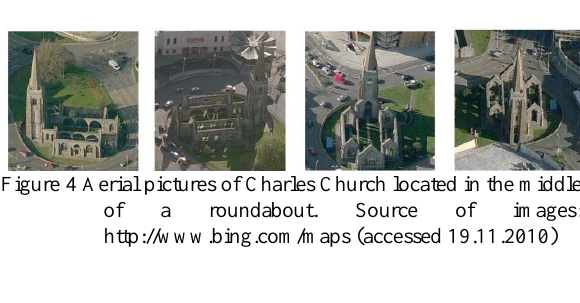
Figure 3 A ruin of Charles Church in Plymouth.